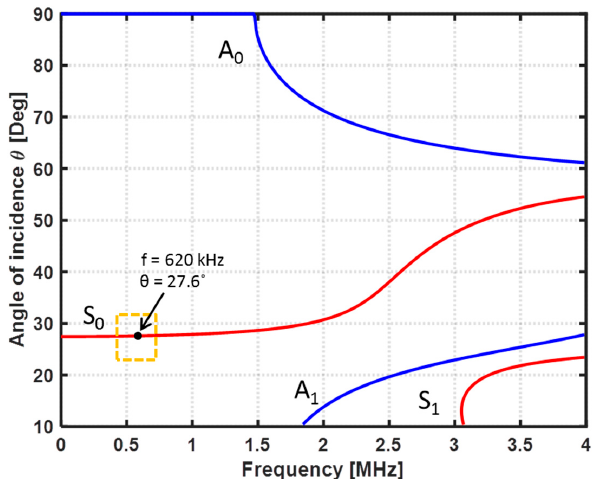
Figure 4. Wavelength for each mode.